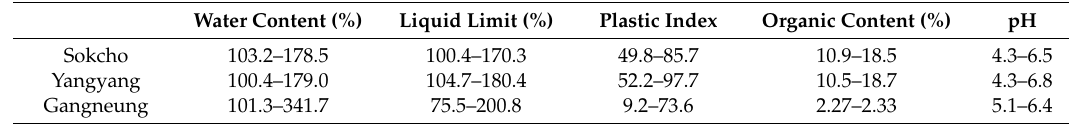
Table 1. Characteristics of organic soil in Yeongdong area (Jang [21]).